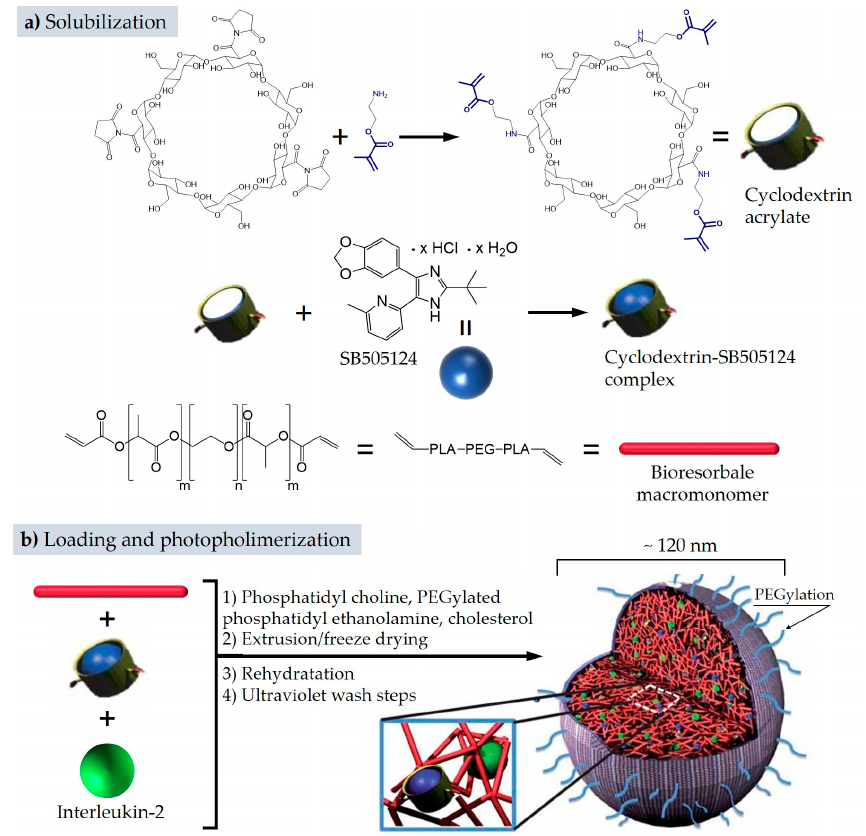
Figure 8. Overall structure of the nanolipogel with the different components and the preparation steps. The cyclodextrin-methacrylate is represented as a hollow cylinder that hosts the transforming growth factor- β inhibitor SB505124 (blue sphere). Adapted by permission from Springer Nature: Nature Materials [79], Copyright 2012.